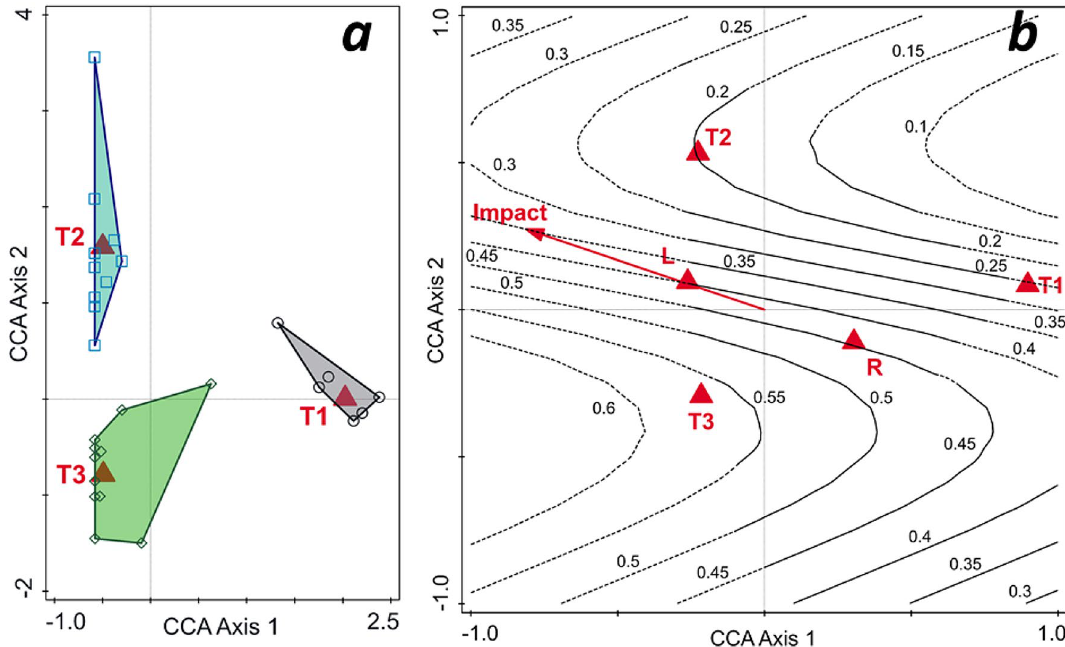
Figure 1. Canonical correspondence analysis (CCA) of mollusk communities: ( a ) classification diagram of sampling sites based on period (as predictors): T1—XIXth century, T2—1995–2000, T3—2020 (adjusted explained variation 23.6%; first axis accounts for 17.6% the second for 6.0%, both axes are significant, p = 0.001); ( b ) CCA diagram of species occurrence constrained by environmental predictors (period, habitat: L—lakes, lentic sector in reservoirs, R—river, lotic sectors, and Impact—human impact) with functional diversity expressed as Rao quadratic entropy index (FD (Rao)) isolines plotted by generalized additive models (GAM) on the ordination space (adjusted explained variation 28.36%; first axis accounts for 16.3%, the second for 6.0%, both axes are significant, p = 0.001)